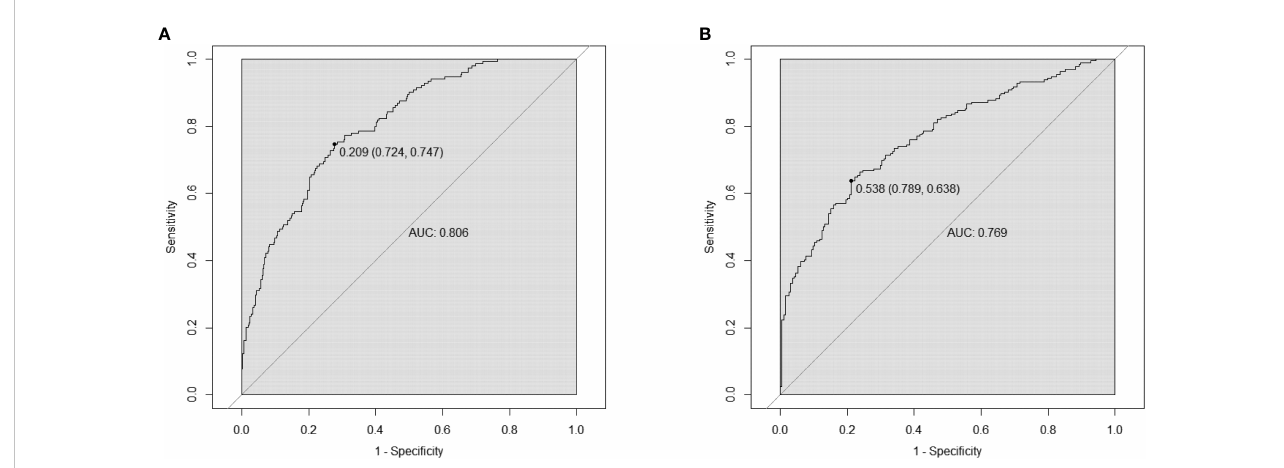
FIGURE 4 Receiver operating characteristic (ROC) curves of nomograms in the training dataset and validation dataset, respectively. (A) The AUC value of the training dataset is 0.808, 95% CI: 0.770 – 0.842 ( p < 0.05). (B) The AUC value of the validation dataset is 0.769, 95% CI: 0.722 – 0.815 ( p <